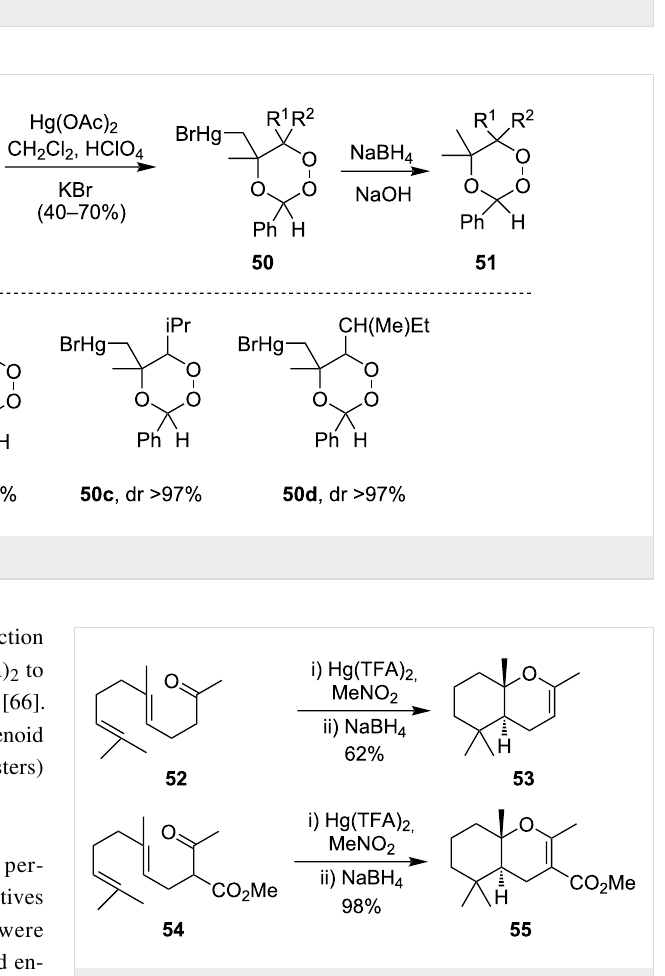
Scheme 17: Hg(II)-salt-induced cyclic peroxide formation.